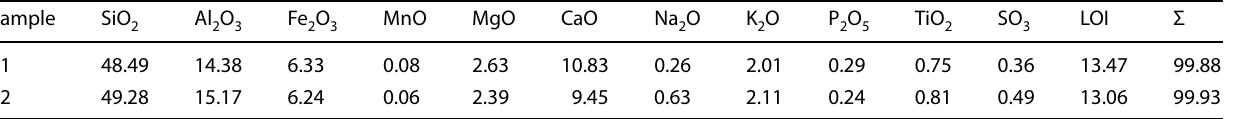
Whole-rock analysis of major elements (oxide wt.%) with the integration